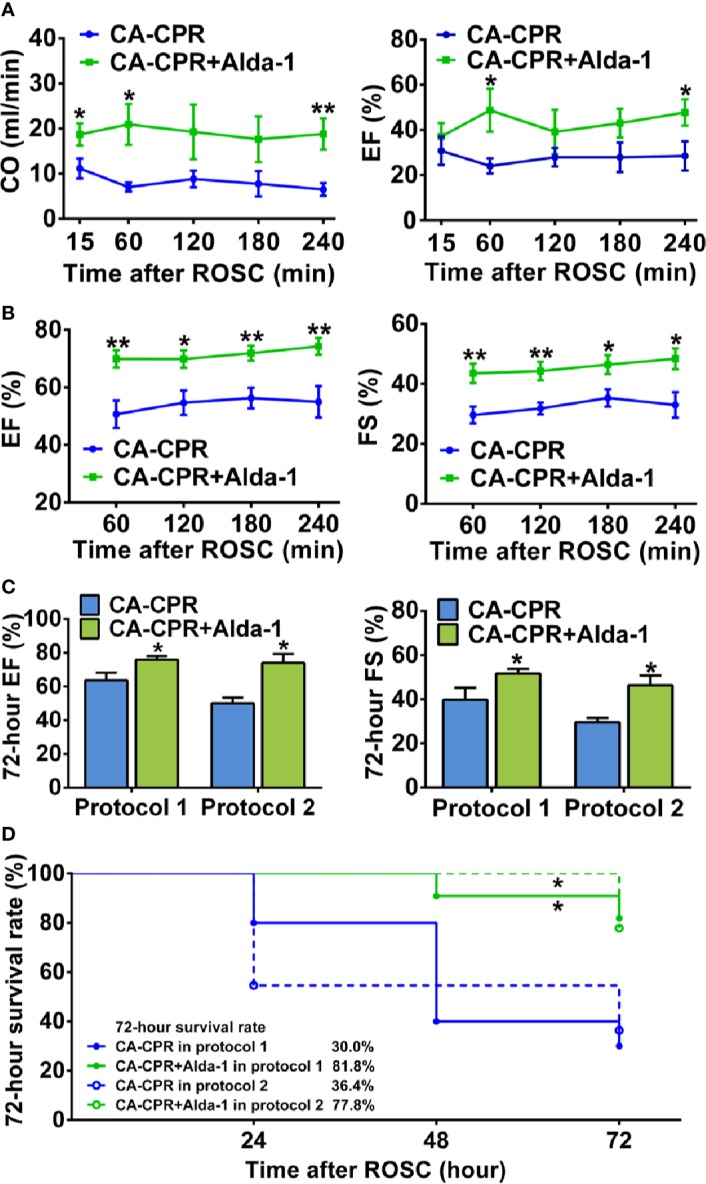
The effect of ALDH2 activation by Alda-1 on post-cardiac arrest myocardial dysfunction and survival rate. (A) Left ventricular cardiac output (CO) and ejection fraction (EF) evaluated by Millar pressure-volume catheter within 4 h after ROSC in protocol 1 of the ALDH2 activation study (n = 6 animals per group). (B) Left ventricular EF and fractional shortening (FS) evaluated by echocardiography within 4 h after ROSC in protocol 2 of the ALDH2 activation study (n = 9 animals per group). (C) Left ventricular EF and FS evaluated by echocardiography at 72 h after ROSC in the two protocols of the ALDH2 activation study (n = 3–9 animals per group). (D) Kaplan-Meier survival curves within 72 h after ROSC in the two protocols of the ALDH2 activation study. Myocardial function between groups was compared by Student’s t-test and time-based measurements within each group were compared by repeated-measures ANOVA. The survival rate between groups was compared by the log-rank test. Data are presented as mean ± SEM. *P < 0.05, **P < 0.01 versus CA-CPR group.